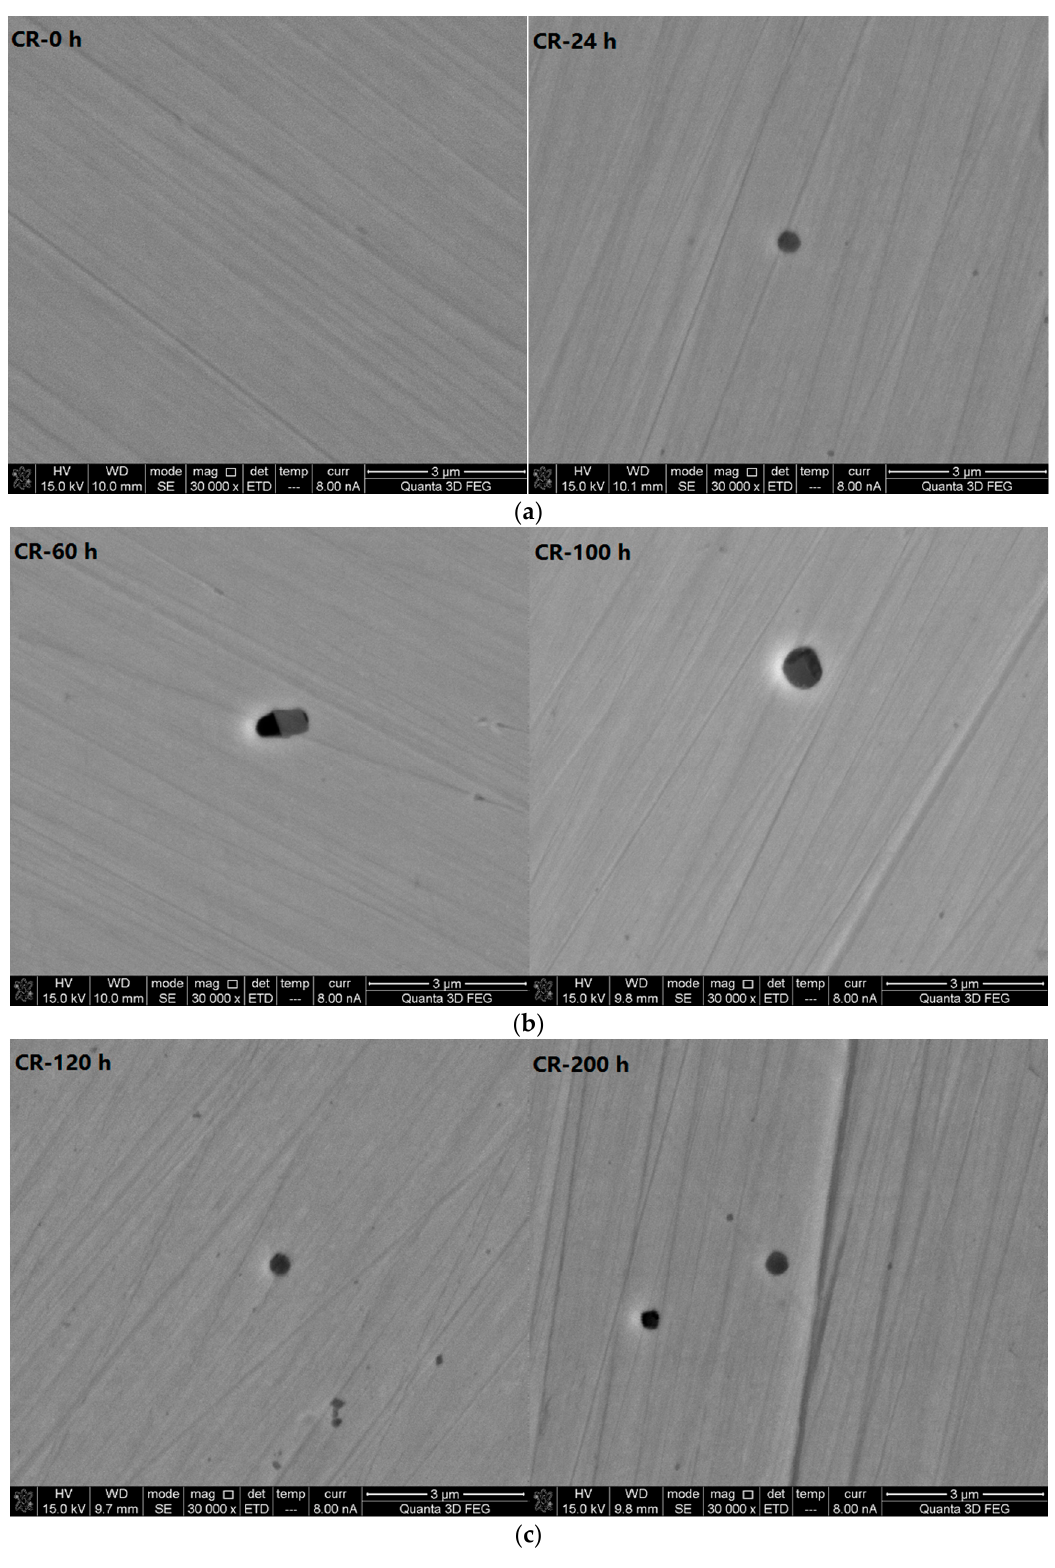
Figure 8. Scanning electron microscope photos (30,000× magnification) of corrosion-resistant alloy steel bars at different corrosive exposure times. ( a ) Micrograph of CR at 0 and 24 h; ( b ) Micrograph of CR at 60 and 100 h; and ( c ) Micrograph of CR at 120 and 200 h.